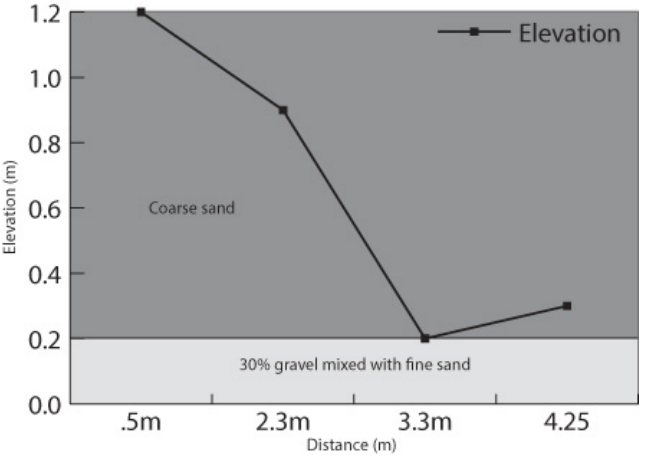
Figure 14. Profile and soils of a surveyed bank on a channel bar in the Santa Clara River measured at site S2.